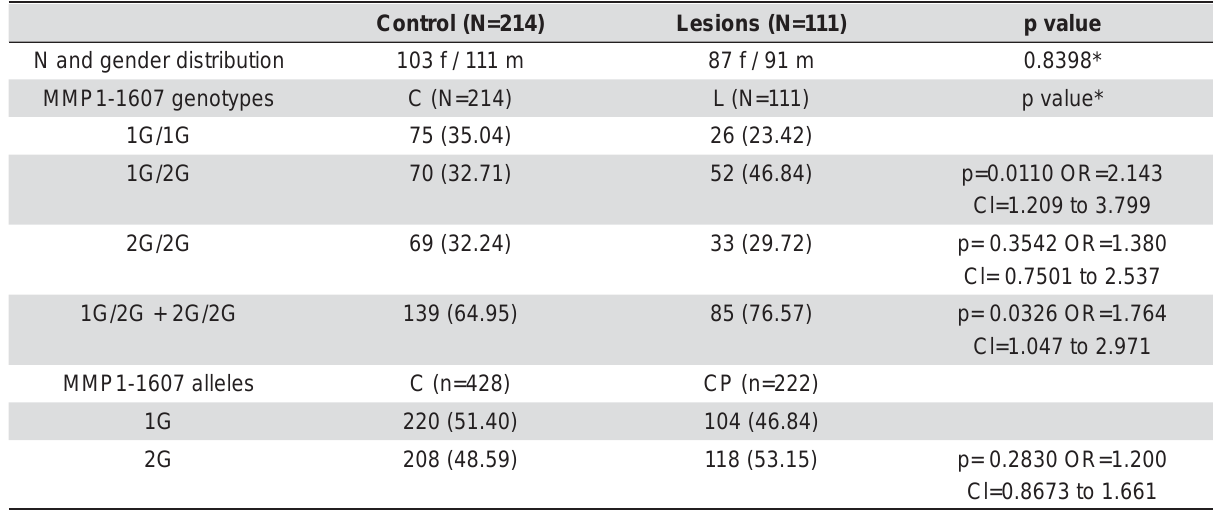
(cid:13)(cid:3)(cid:70)(cid:75)(cid:76)(cid:16)(cid:86)(cid:84)(cid:88)(cid:68)(cid:85)(cid:72)(cid:3)(cid:87)(cid:72)(cid:86)(cid:87)(cid:15)(cid:3)(cid:13)(cid:13)(cid:88)(cid:81)(cid:83)(cid:68)(cid:76)(cid:85)(cid:72)(cid:71)(cid:3)(cid:87)(cid:3)(cid:87)(cid:72)(cid:86)(cid:87)(cid:30)(cid:3)(cid:50)(cid:53)(cid:29)(cid:3)(cid:82)(cid:71)(cid:71)(cid:86)(cid:3)(cid:85)(cid:68)(cid:87)(cid:76)(cid:82)(cid:30)(cid:3)(cid:38)(cid:79)(cid:29)(cid:3)(cid:70)(cid:82)(cid:81)(cid:191)(cid:71)(cid:72)(cid:81)(cid:70)(cid:72)(cid:3)(cid:76)(cid:81)(cid:87)(cid:72)(cid:85)(cid:89)(cid:68)(cid:79)